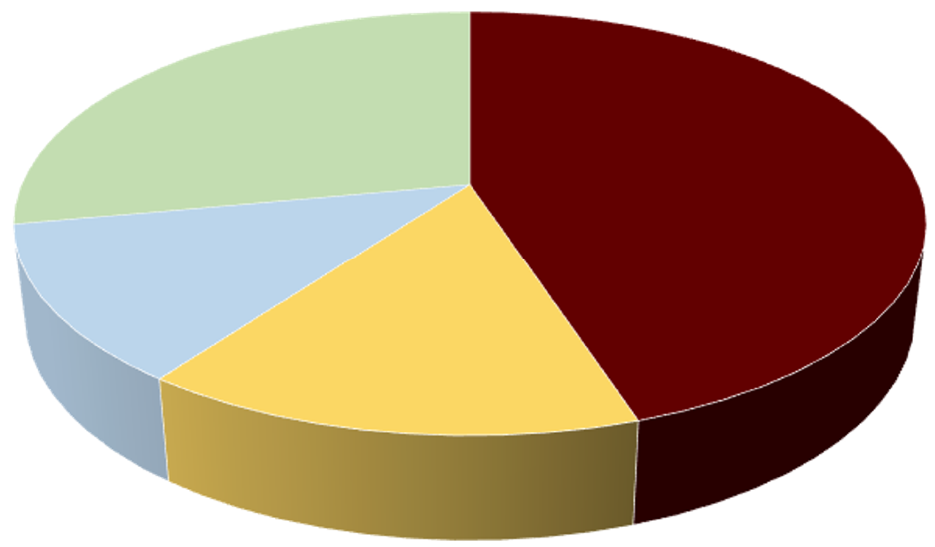
Figure 3. Depiction of the incidence of infective endocarditis according to the previous cardiac history in a French population study reporting data from 497 adults. Red dark box, no known cardiac disease; yellow box, prosthetic valve with or without intracardiac device; blue box, intracardiac device; green box, other cardiac device including individuals who received LVAD. Abbreviation; LVAD, left ventricular assist device.